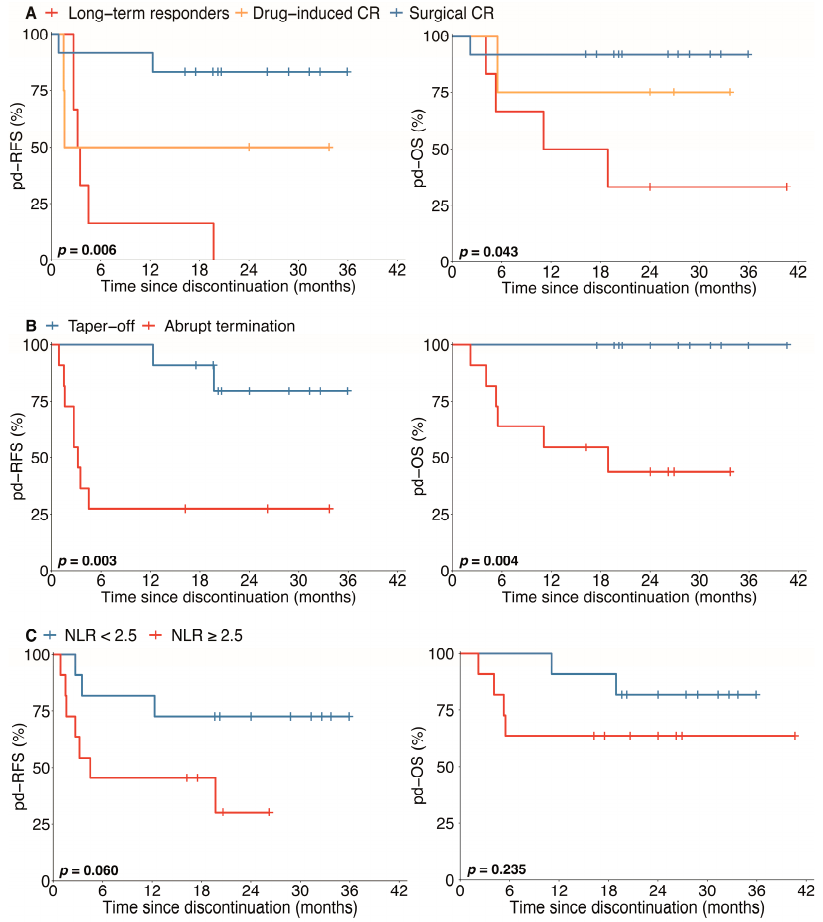
Figure 4. Kaplan–Meier curves for pd-RFS and pd-OS. Pd-RFS = disease-free survival since the dis- continuation of TKI, Pd-OS = overall survival since the discontinuation of TKI, NLR = neutrophil- to-lymphocyte ratio, and CR = complete response. Kaplan–Meier analysis estimates show the dis- tribution of RFS and OS for all patients with TKI discontinuation analysis ( n = 22). Crosses indicate censored patients. Surgical CR before discontinuation ( A ) was independently associated with im- proved survival ( p = 0.006 for pd-RFS and p = 0.043 for pd-OS). Discontinuation by tapering off ( B ) significantly improved the RFS and OS of patients with TKI therapy ( p = 0.003 for pd-RFS and p = 0.004 for pd-OS). A lower NLR ( C ) might be a prognostic marker in pd-RFS ( p = 0.060, borderline significance), while it showed no sensitivity in pd-OS ( p = 0.235). 3.4. The Potential Benefit of Drug Taper-Off Strategy Since AA-TKI withdrawal with a taper-off strategy is associated with a better prog- nosis compared with abrupt discontinuation, we next address the hypothesis that it is due to prolonged disease quiescence and/or slower tumor growth following relapse. Interest- ingly, the disease progression risk was significantly higher in abrupt discontinuation pa- tients compared to taper-off patients ( p = 0.008) (Supplementary Figure S2A). Further- more, we found that the growth rate of the relapsed disease tends to be slower than that of the baseline before initiating AA-TKIs (median TDT 58.08 versus 32.23 days, borderline significance, p = 0.054) in taper-off patients (Supplementary Figure S2B). In contrast, no